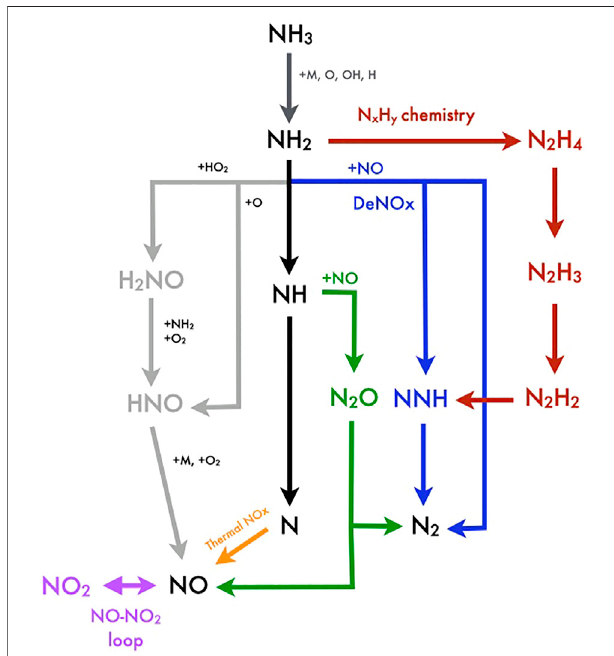
FIGURE5| GenericschemeforNH 3 oxidationchemistry,NO x formation routes, DeNO x , N x H y , and N 2 O chemistry, and the NO-NO 2 loop.